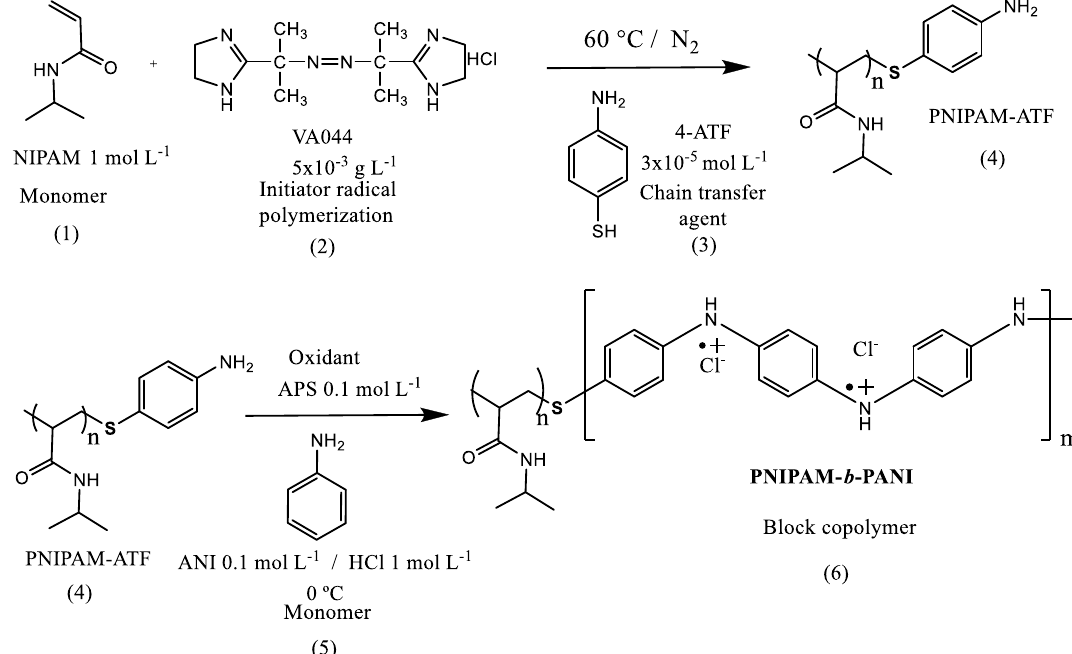
Figure 1. Schematic representation of the PNIPAM- b -PANI synthesis. PNIPAM = Poly( N - isopropylacrylamide); PANI = polyaniline; ATF = aminothiophenol; ANI = aniline; APS = ammonium peroxydisulfate.